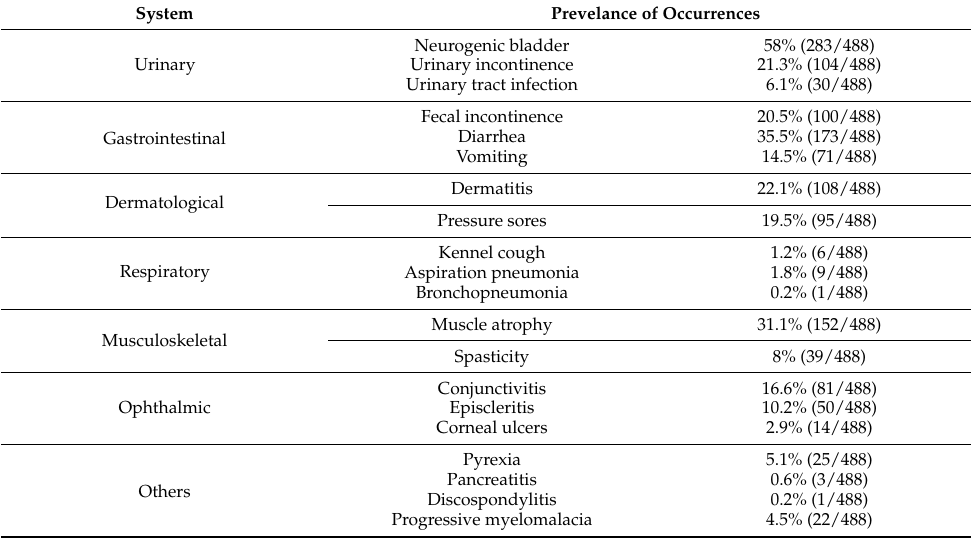
Table 4. Prevalence of clinical occurrences in the study population ( n =